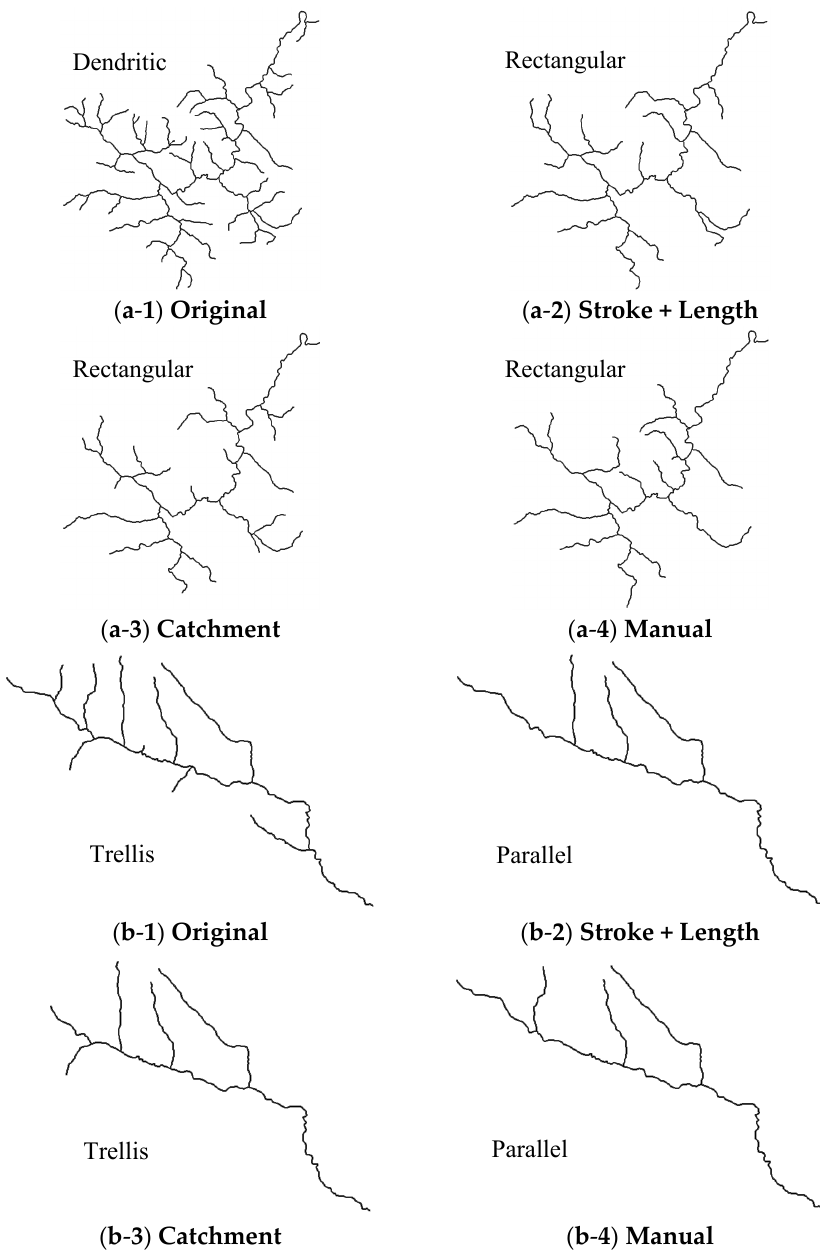
Figure 11. Some generalized river networks with changed patterns. ( a - 1 ) Original; ( a - 2 ) Stroke + Length; ( a - 3 ) Catchment; ( a - 4 ) Manual; ( b - 1 ) Original; ( b - 2 ) Stroke + Length; ( b - 3 ) Catchment; ( b - 4 ) Manual.